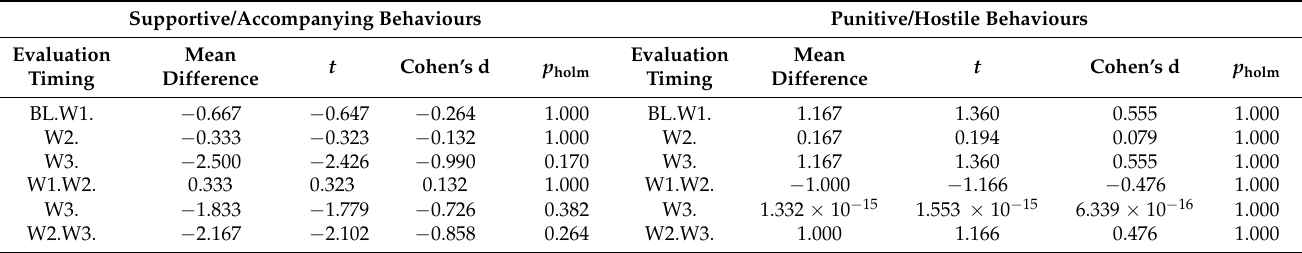
Table 10. Effect size of the programme in family interactions for control